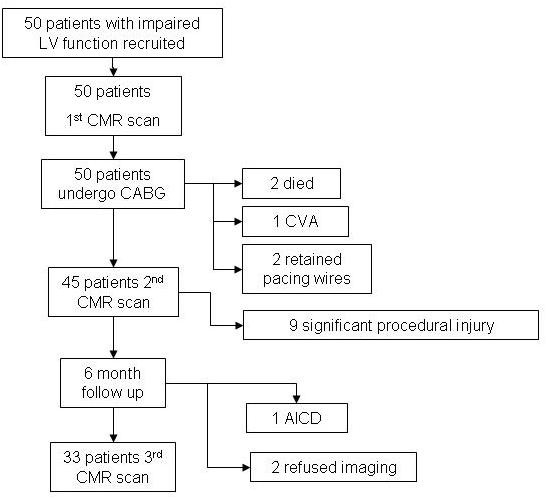
Consort statement diagram of trial participants. AICD, automated implantable cardiac defibrillator; CABG, coronary artery bypass grafting; CMR, cardiovascular magnetic resonance imaging; CVE, cerebro-vascular accident; LV, left ventricular.